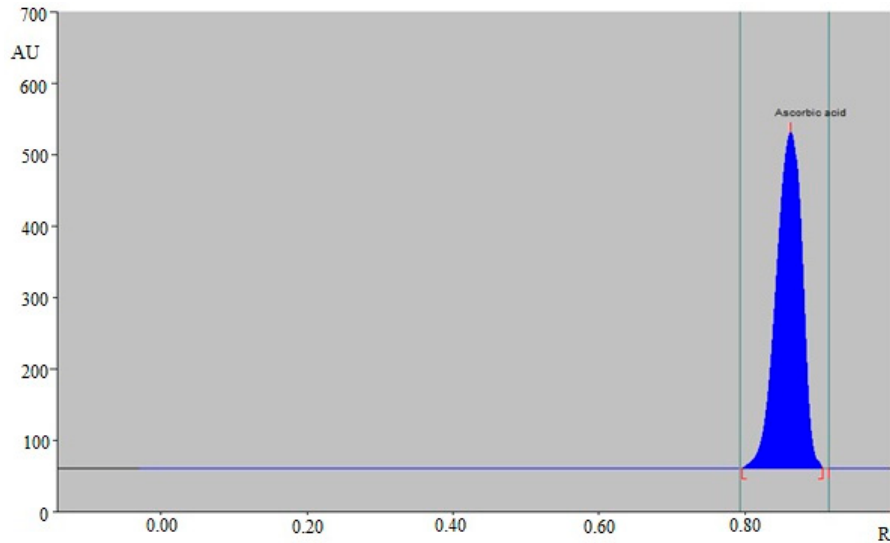
Figure 2. Representative HPTLC densitogram of standard AA for the greener HPTLC method.